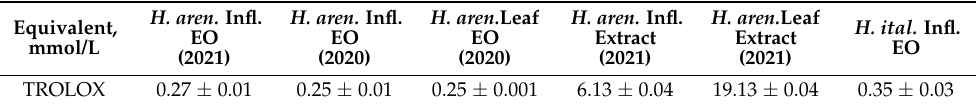
Table 3. Antioxidant activity of H. arenarium inflorescence and leaf, and H. italicum inflorescence essential oils and extracts using DPPH • assay.